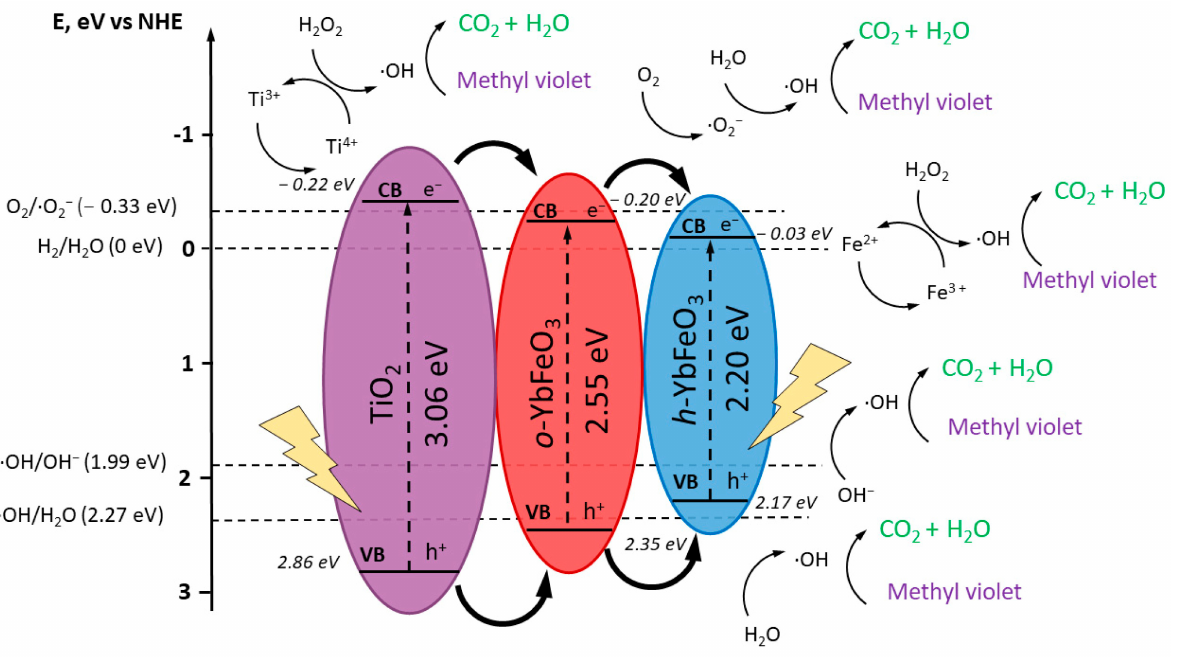
Figure 9. Schematic mechanism of photo-Fenton-like degradation of MV over o -YbFeO 3 / h - YbFeO 3 /TiO 2 heterojunction